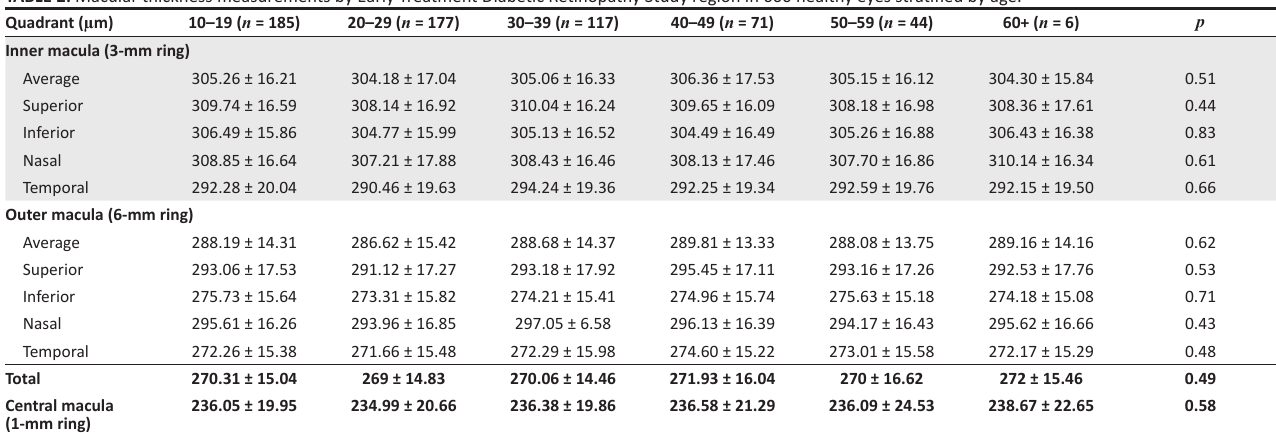
TABLE 2: Macular thickness measurements by Early Treatment Diabetic Retinopathy Study region in 600 healthy eyes stratified by age. Quadrant ( µ